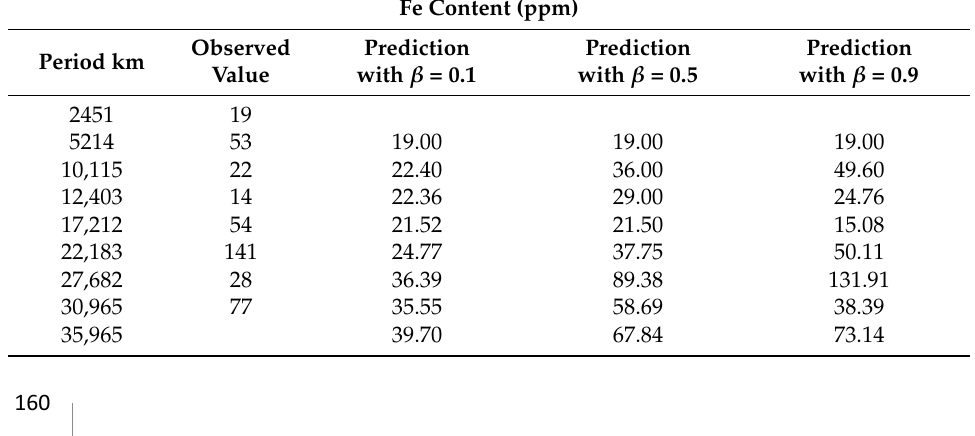
Table 2. Application of exponential smoothing-Fe (ppm) content.